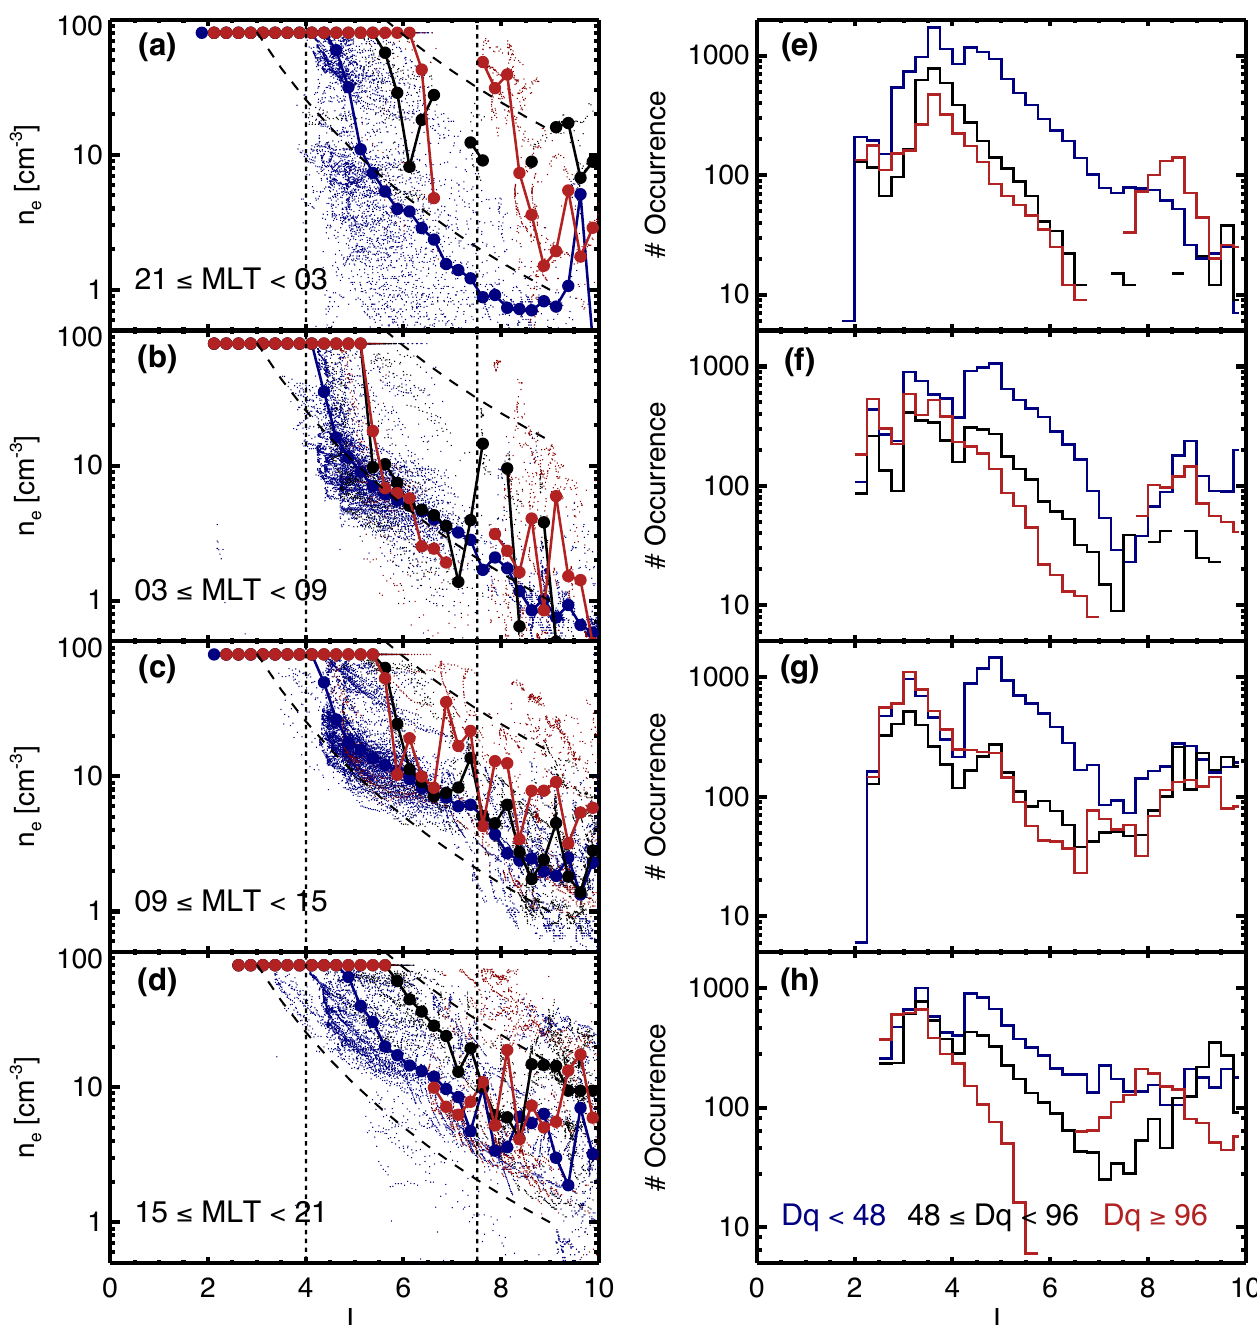
Fig. 9. Distribution of electron density versus L , using a resolution of 0.25 in L -value, over a region covering the latitudinal range − 30 ◦ ≤ MLat ≤ 30 ◦ . Panels display identical quantities as in Fig. 8, using the same colour code. Dashed lines show distributions in L − 4 .